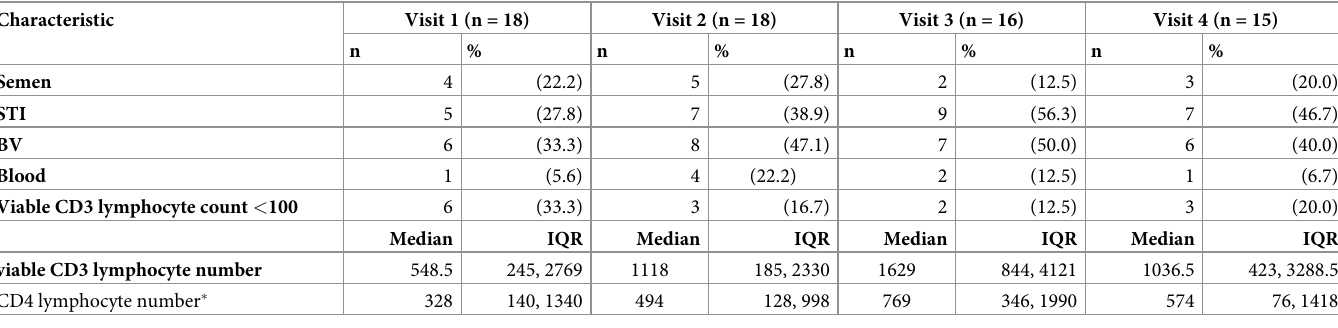
Table 2. Time-varying characteristics of CVL specimens by study visit. Characteristic